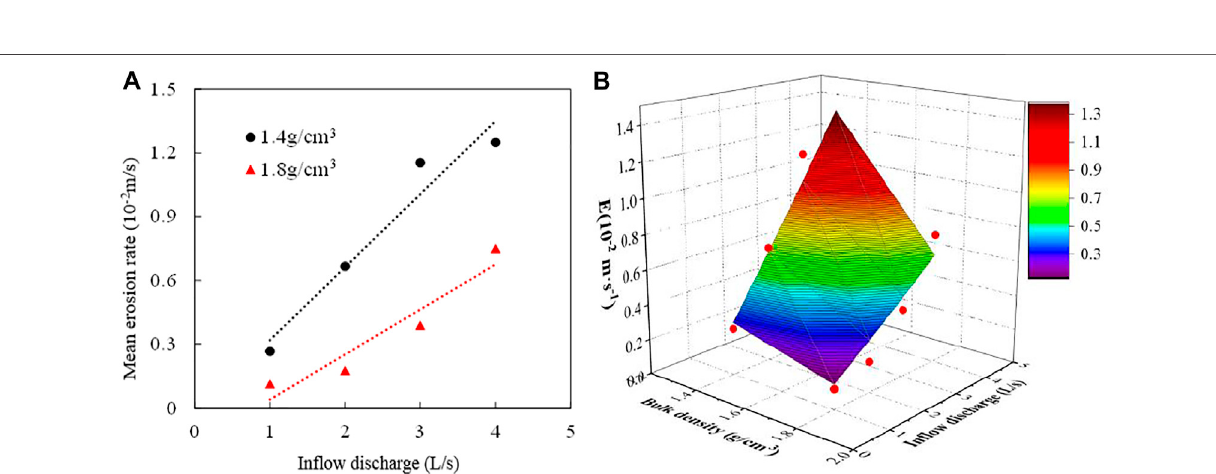
FIGURE 12 | Relationship of the erosion rate with slope and fi ne particle content: (A) relationship between average erosion rate and fi ne particle content with different values of slope, and (B) multivariate nonlinear regression curve.